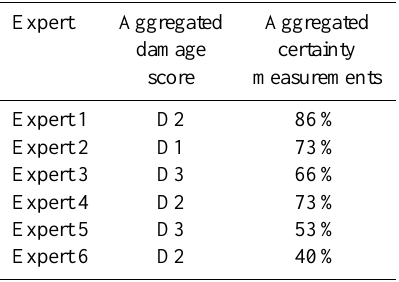
Table 5. Results of the aggregation of the individual expert-based per-façade/roof